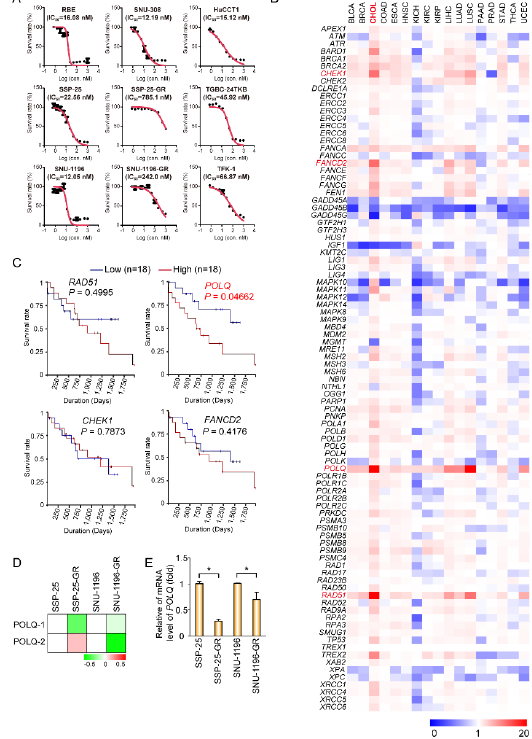
Figure 1. DNA polymerase θ may be involved in gemcitabine resistance in BTC (biliary tract cancer) Figure1. DNApolymerase θ cells. ( A ) Cell viability in various concentrations of GEM (gemcitabine). The values (means ± SD) are from two data points and are expressed as a percentage relative to that of the cells without gemcitabine treatment. The IC 50 (half-maximal inhibitory concentration) values for gemcitabine in BTC cell lines are shown in each panel. ( B ) A heat map showing the relative mRNA expression of 92 DNA damage repair (DDR) genes in 17 different cancers from cancer tissues, compared to their normal tissues. The data were obtained from The Cancer Genome Atlas (TCGA) and analyzed by starBase (http://starbase.sysu.edu.cn/index.php). Red pixels indicate upregulated expression; blue pixels represent downregulated expression. ( C ) The data of the Kaplan–Meier survival curves for overall survival in 36 patients with cholangiocarcinoma were obtained from TCGA and analyzed by UCSC Xena (https://xena.ucsc.edu/). The p values are shown in each panel. ( D ) A heat map showing the relative mRNA expression of POLQ using different probes (POLQ-1 and POLQ-2) from resistant cells (SSP-25-GR and SNU-1196-GR) compared to their parental cells (SSP-25 and SNU-1196). Red pixels indicate upregulated expression; green pixels represent downregulated expression. ( E ) The relative mRNA level of POLQ. The values (means ± SD) are from two independent experiments, and are presented as the fold change relative to the level of parental cells (SSP-25 and SNU-1196). * p < 0.05 by Mann–Whitney U test. We further investigated whether ATM is a potential target in GEM-resistant BTCs. We first tested the ATM inhibitor AZD0156 IC 50 values in parental and GEM-resistant cell lines. The AZD0156 IC 50 values in GEM-resistant cell lines (SSP25-GR and SNU1196-GR) were reduced compared to those in the parental cells (SSP-25 and SNU1196) (Figure 2A). To further confirm the effect of DNA polymerase θ on ATM inhibitor sensitivity in BTCs, DNA polymerase θ expression was suppressed